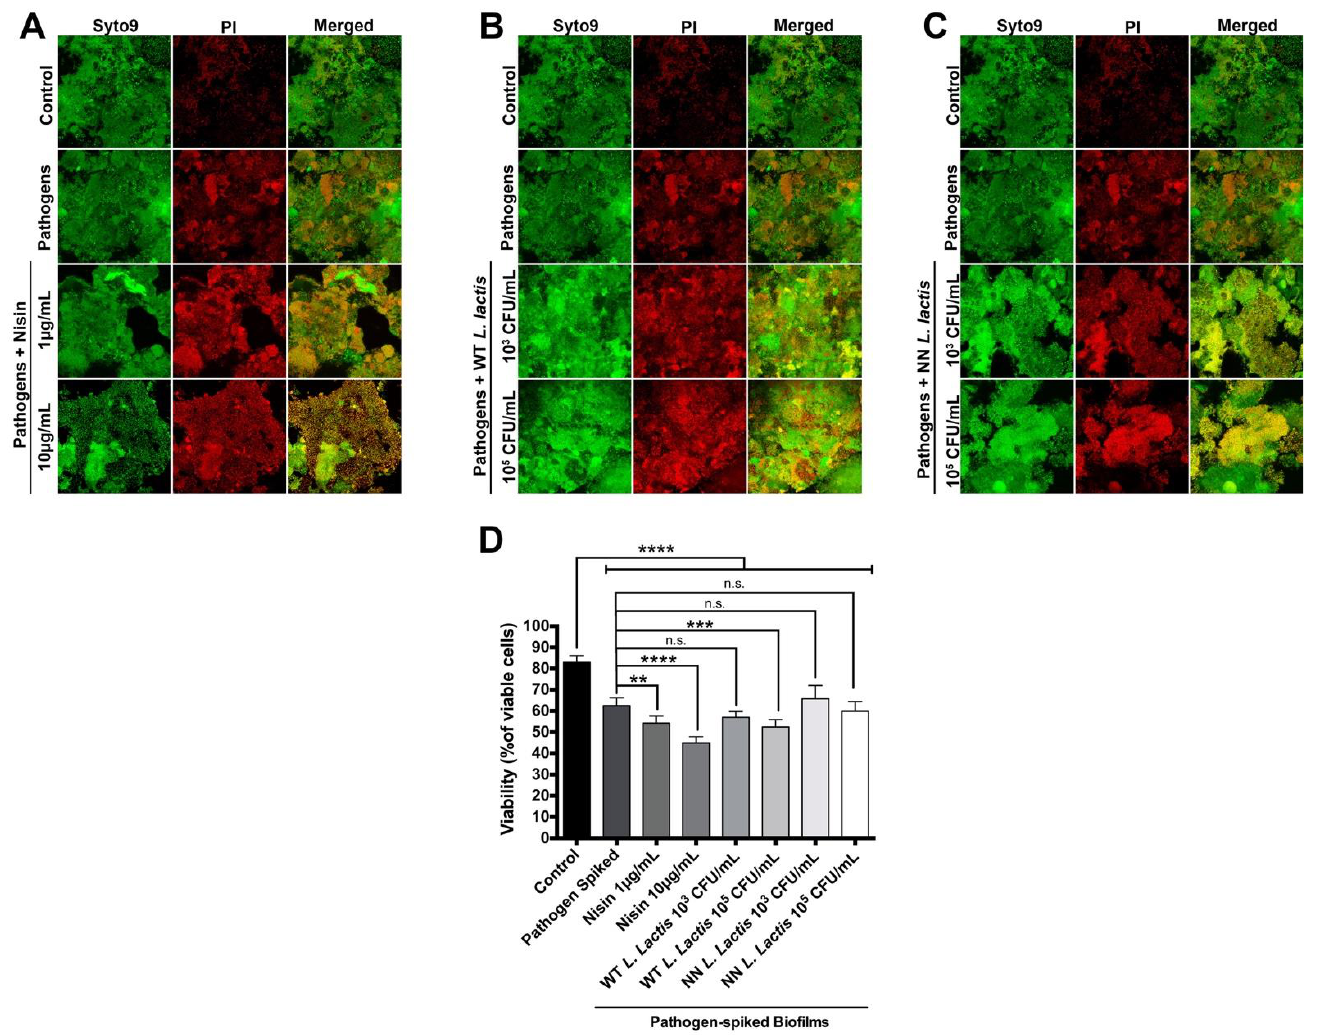
Figure 3. Nisin effectively disrupts pathogen-spiked oral biofilms on Laser-Lok ® grade V titanium discs. Pathogen-spiked biofilms were treated with either nisin ( A ), WT L. lactis ( B ) or NN L. lactis ( C ) for 24 h. ( A – C ) Representative images of fluorescently labeled biofilms are shown. The columns, from left to right, represent the different staining dyes/protocols; SYTO9 is a live cell stain, propidium iodide (PI) is a dead-cell stain, and the merged images show the overlap of both stains. The rows represent the different treatments. ( D ) Quantification of bacterial viability assessed from the confocal images is shown. n.s. means not significant; ** means p ≤ 0.01; *** means p ≤ 0.001; and **** means p ≤ 0.0001 between the marked samples.